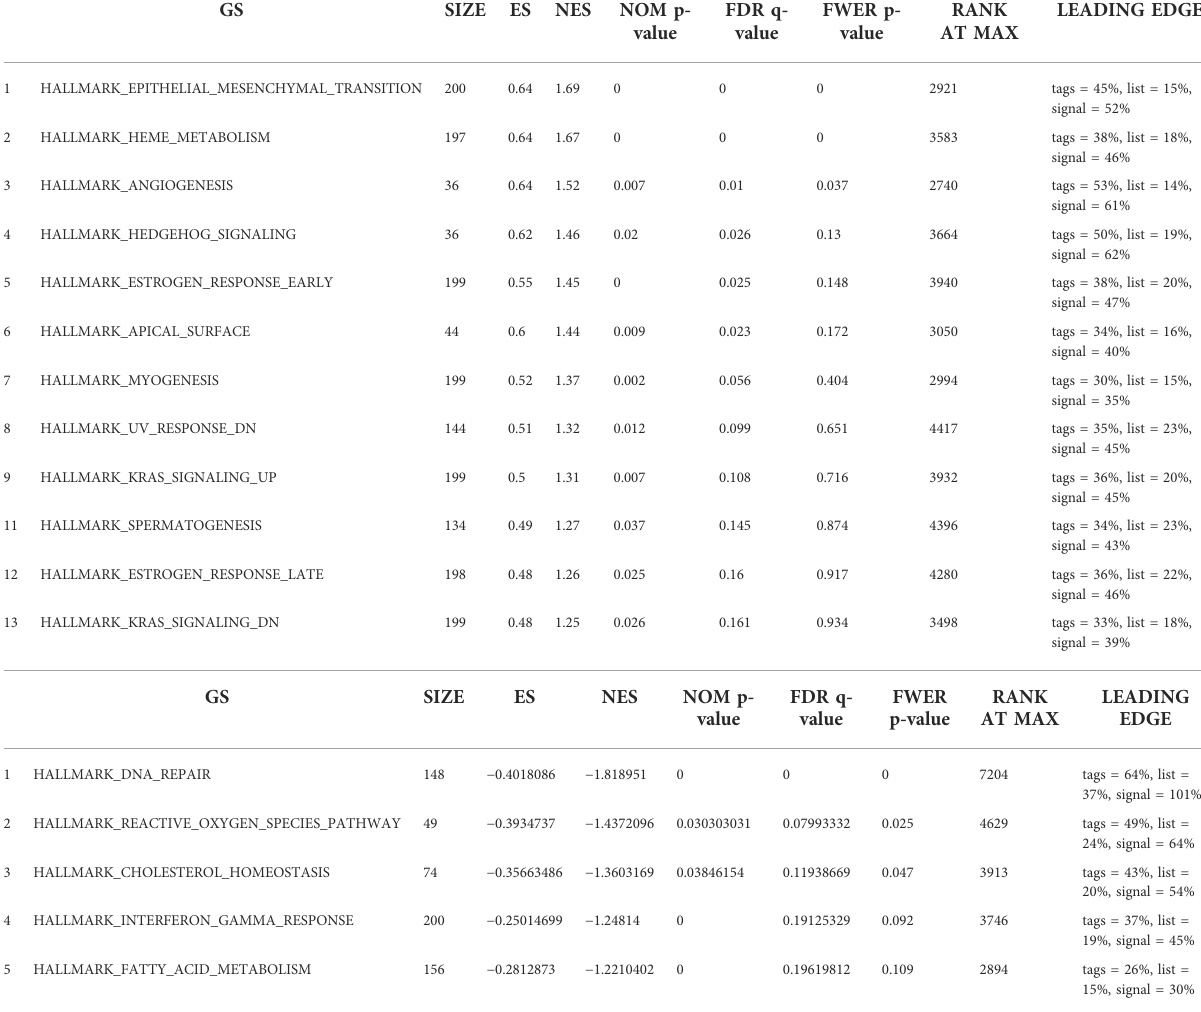
TABLE 2 Seventeen items from gene set enrichment analysis. (A) Gene sets enriched in phenotype SLC25A21 low. (B) Gene sets enriched in phenotypeSLC25A21 high. GS SIZE ES NES NOM p-